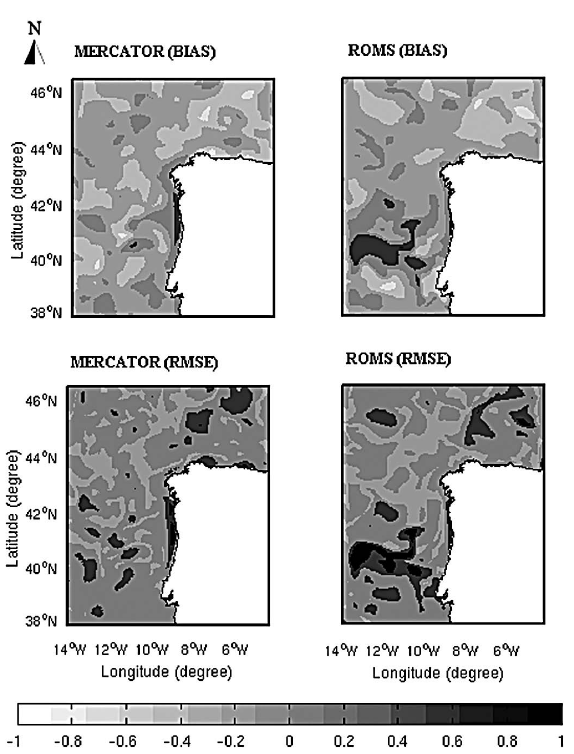
MERCATOR model and (right) ROMS model.